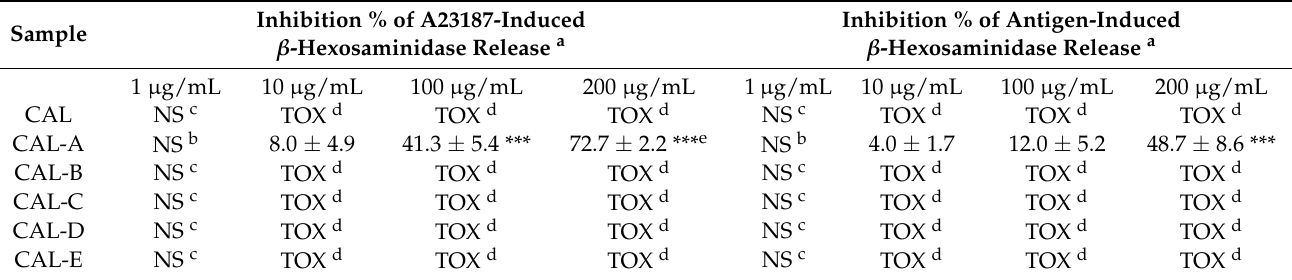
Table 3. Anti-allergic effects of C. aethiopica leaf total methanol extract and its fractions at different concentrations using degranulation assay in RBL-2H3 cell